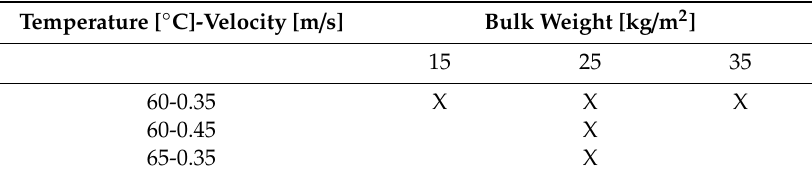
Table 1. Experimental plan for drying of Hallertauer